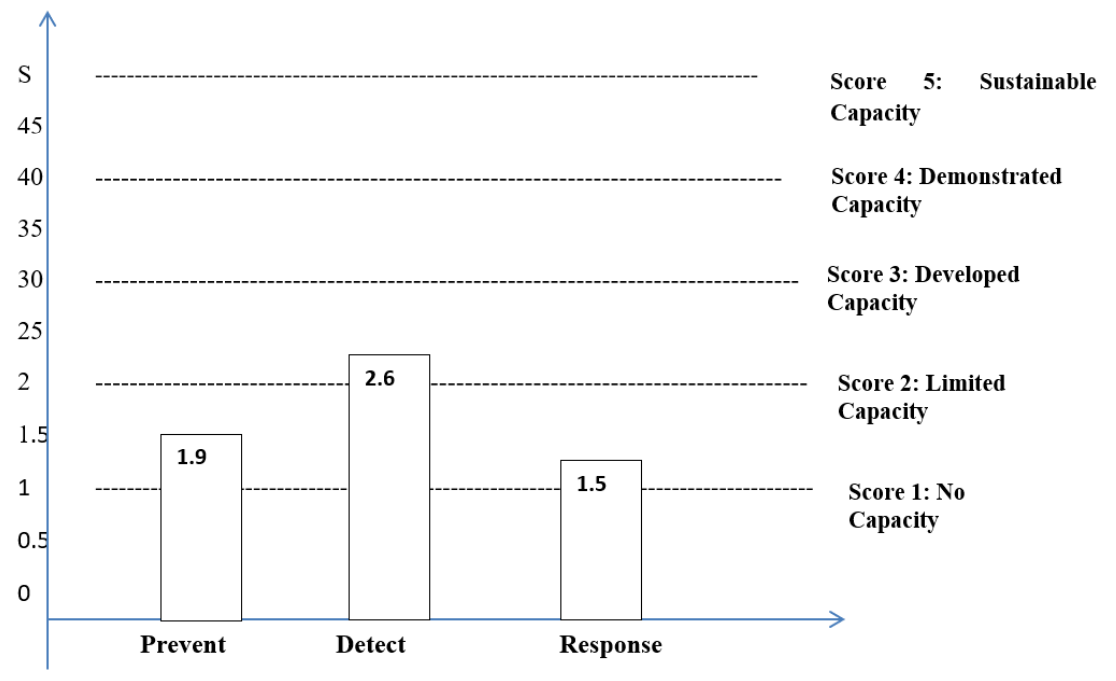
Figure 3. Nigeria’s response to COVID-19 pandemic. Source: Dixit, Ogundeji, and Owujekwe (2020), see Note 21.